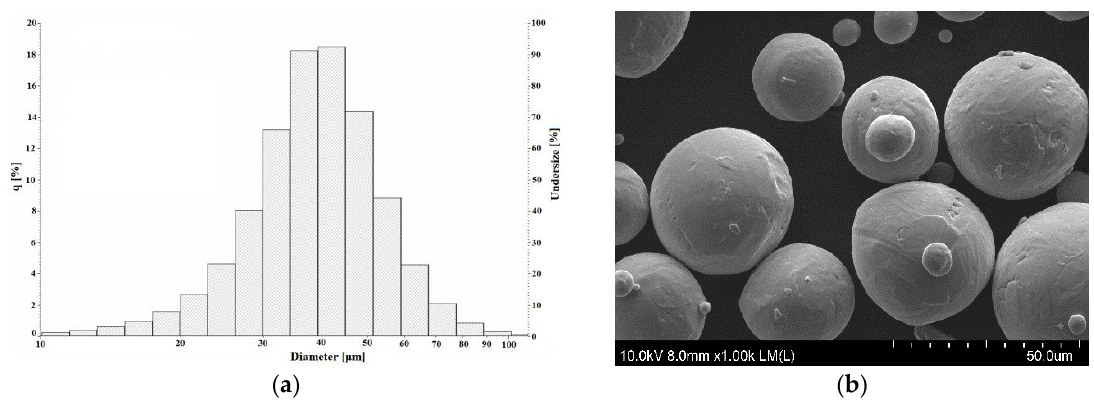
Figure 3. The titanium powder size distribution ( a ); and morphology ( b ).